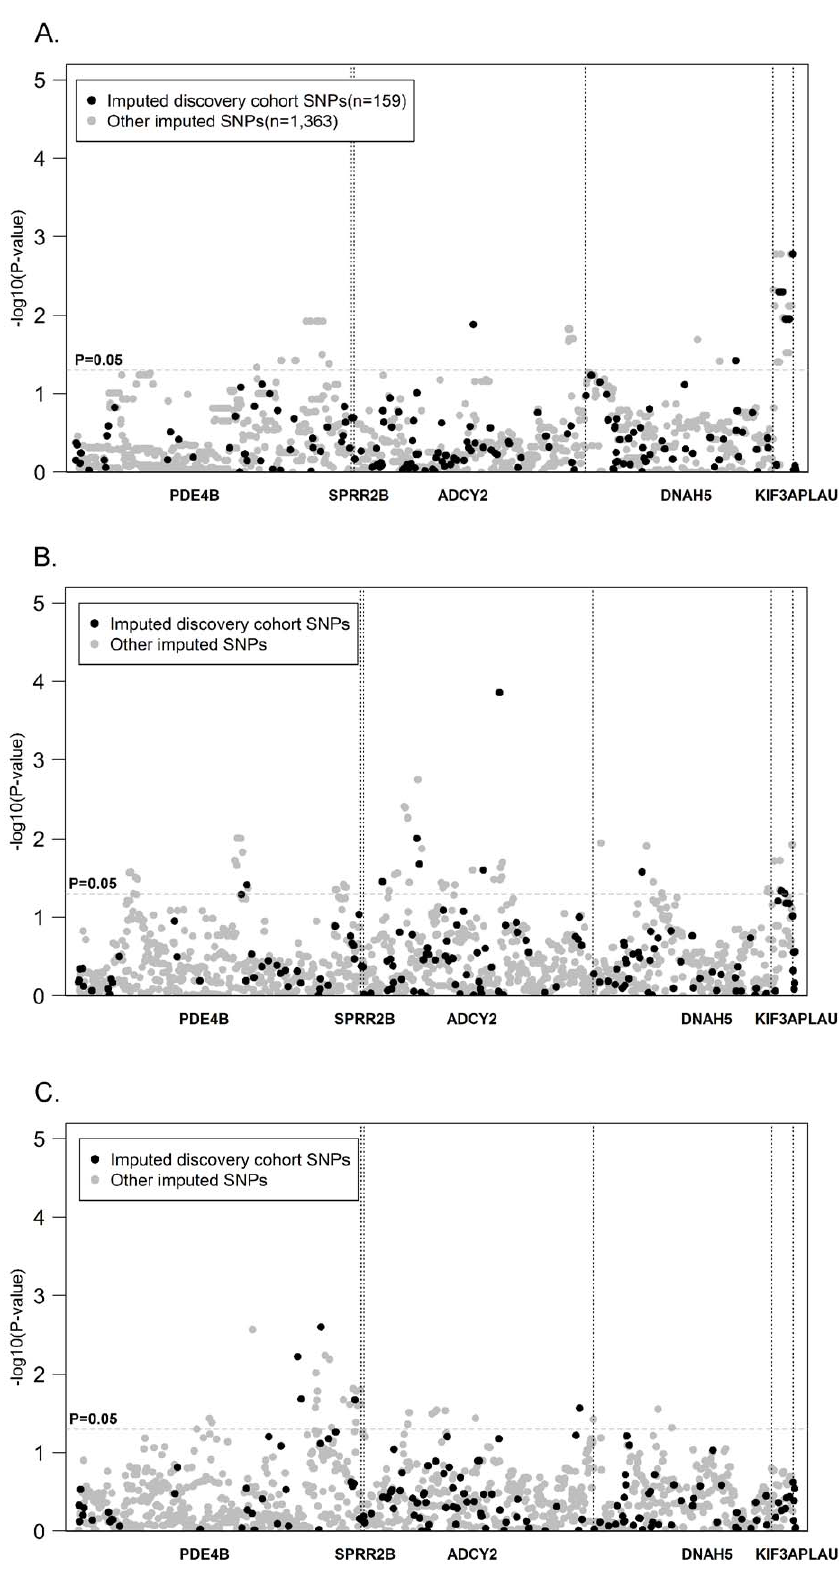
Figure 3. Associations with asthma in three additional independent populations. SNPs not genotyped in the study were imputed based on HapMap CEU results (release 22) with MACH software using the available from the Affymetrix 6.0 genotype data. Imputed SNPs were then tested for associations with asthma using PLINK. The dashed line corresponds to a p-value of 0.05. A . Associations in a second Cincinnati-based Caucasian population. B . Asthma associations in the GALA Puerto Rican trios. C . Associations in the GALA Mexican trios. doi:10.1371/journal.pone.0023714.g003 PLoS ONE |